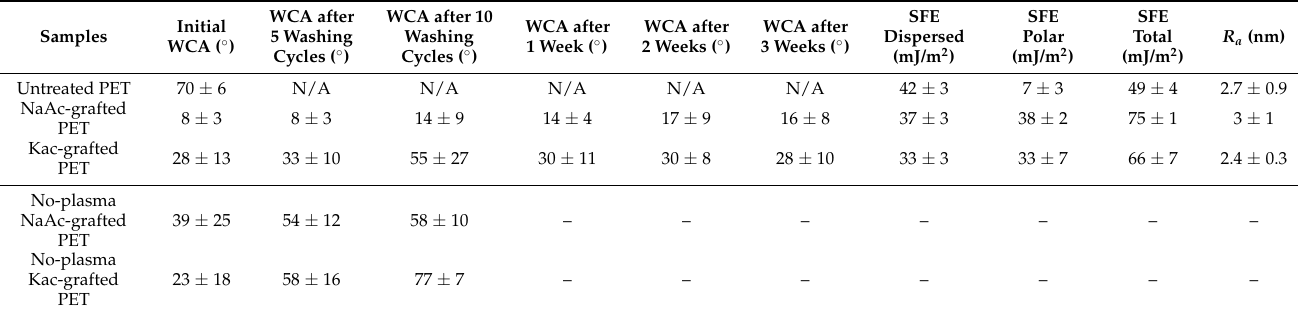
Table 5. WCA, surface energy and average roughness values of the untreated, NaAc-treated and Kac-treated PET